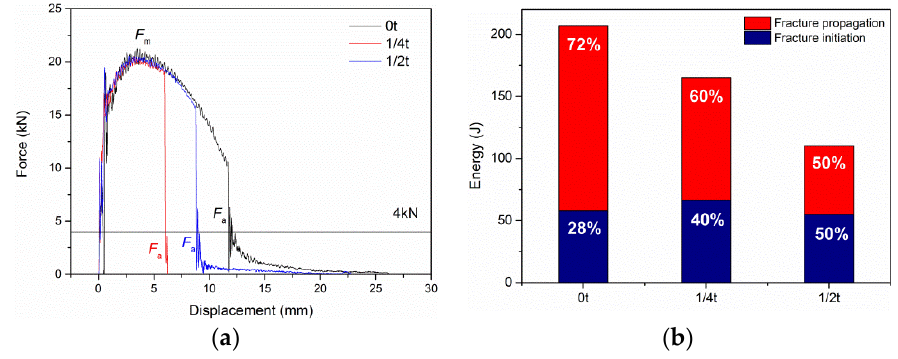
Figure 6. ( a ) Load versus displacement plot of 130 mm-thick steel plate obtained by instrumented impact at −20 °C. The point of crack initiation is indicated by F m and the point of crack arrest is indicated by F a . ( b ) Fracture initiation and propagation energy at −20 °C obtained from load-displacement curves of the instrumented Charpy impact tests.